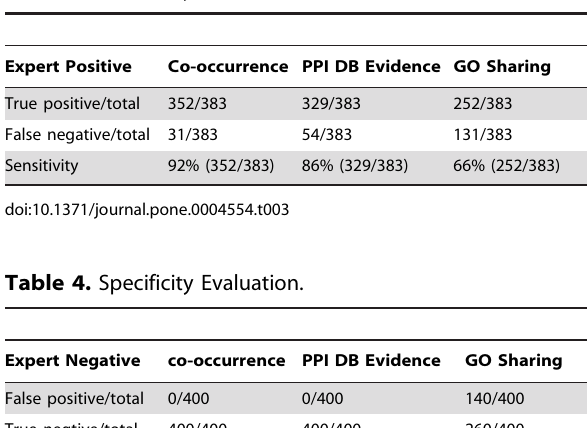
Figure 3. Demonstration of the output results of PPI Finder. Step 1: Our favourite protein name ‘‘dysbindin’’ is searched by selecting ‘‘Gene Name’’. Step 2: Three results of ‘‘dysbindin’’ are returned. The first row showing ‘‘DTNBP1’’ is the one that unifies the protein name to a unique gene ID. Step 3: By clicking the ‘‘DTNBP1’’ gene, the gene-centred page is shown. The summary of the information of the ‘‘DTNBP1’’ gene is shown on the top. Step 4: The 35 co-occurred genes and their co-occurrence times, PPI database evidences, and gene ontologies are shown at the bottom of the gene-centred page with the co-occurred GO terms highlighted. Step 5: By clicking the hyperlink to ‘‘5’’ in the column of ‘‘co-occurrence times’’ of the fourth co-occurred ‘‘SNAPIN’’ gene, it prompts the co-occurred abstracts and the highlighted words of interaction extraction in the